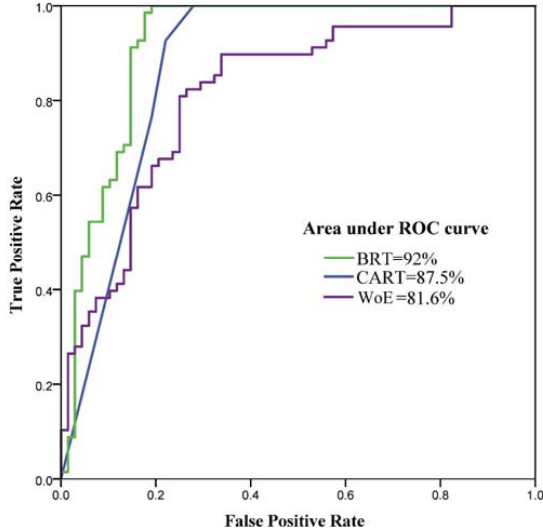
Figure 11. The validation results of the FWS suitability maps obtained from the BRT, CART, and WoE algorithms.